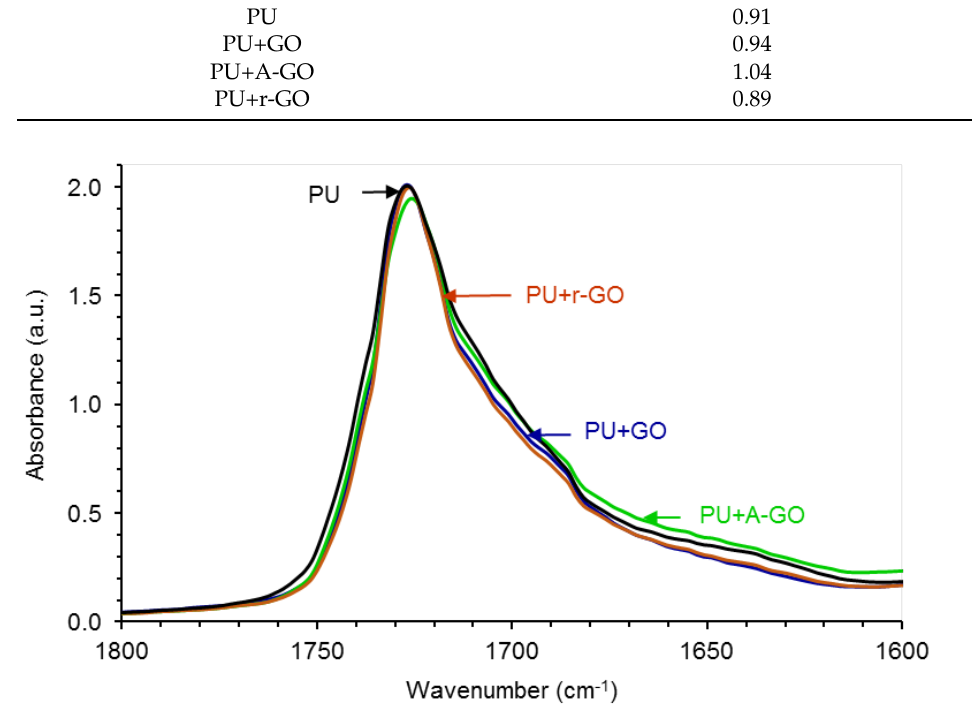
Table 5. Values of the ratios of the intensities of the C-O-C bending (1168 cm − 1 ) with respect to the one of the C=O stretching (1727 cm − 1 ) bands in the ATR-IR spectra of the PUs. Poly(urethane urea) I C-O-C /I C=O PU 0.91 PU+GO 0.94 PU+A-GO 1.04 PU+r-GO 0.89